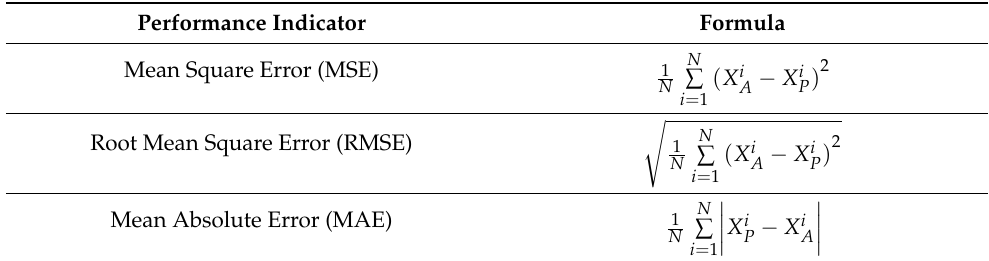
Table 11. Formulas of Performance Criteria.